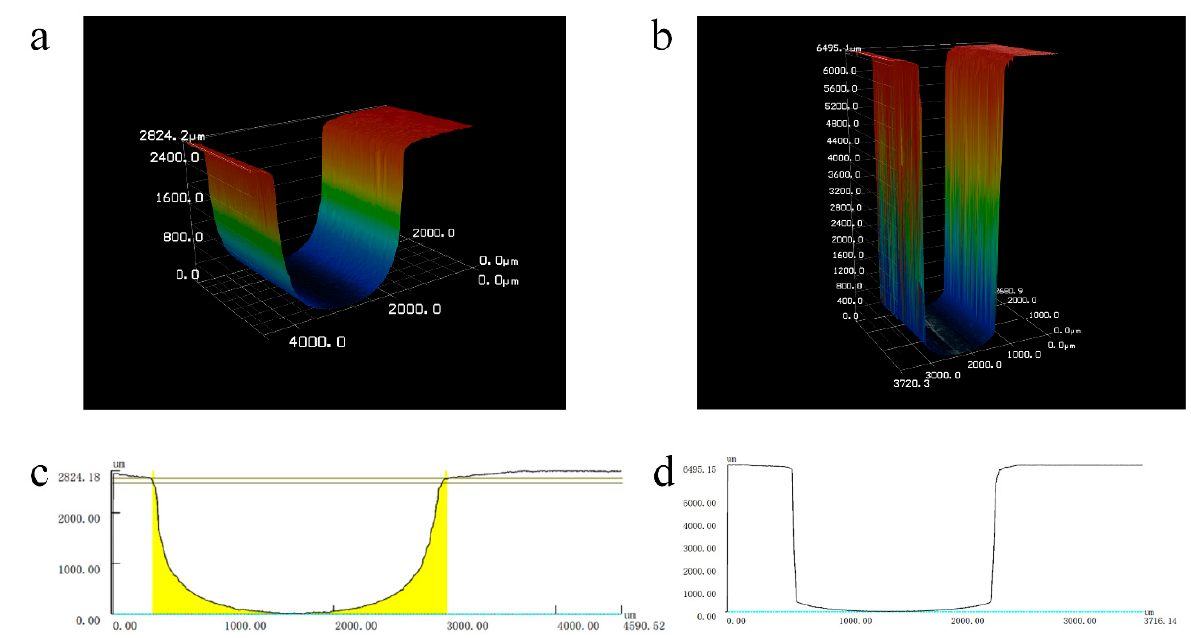
Figure 11. ( a , b ) Three-dimensional profiles of the deep and narrow microgrooves fabricated by laser and shaped tube electrochemical milling. ( c , d ) The cross-sectional profile of the correspondent microgrooves.